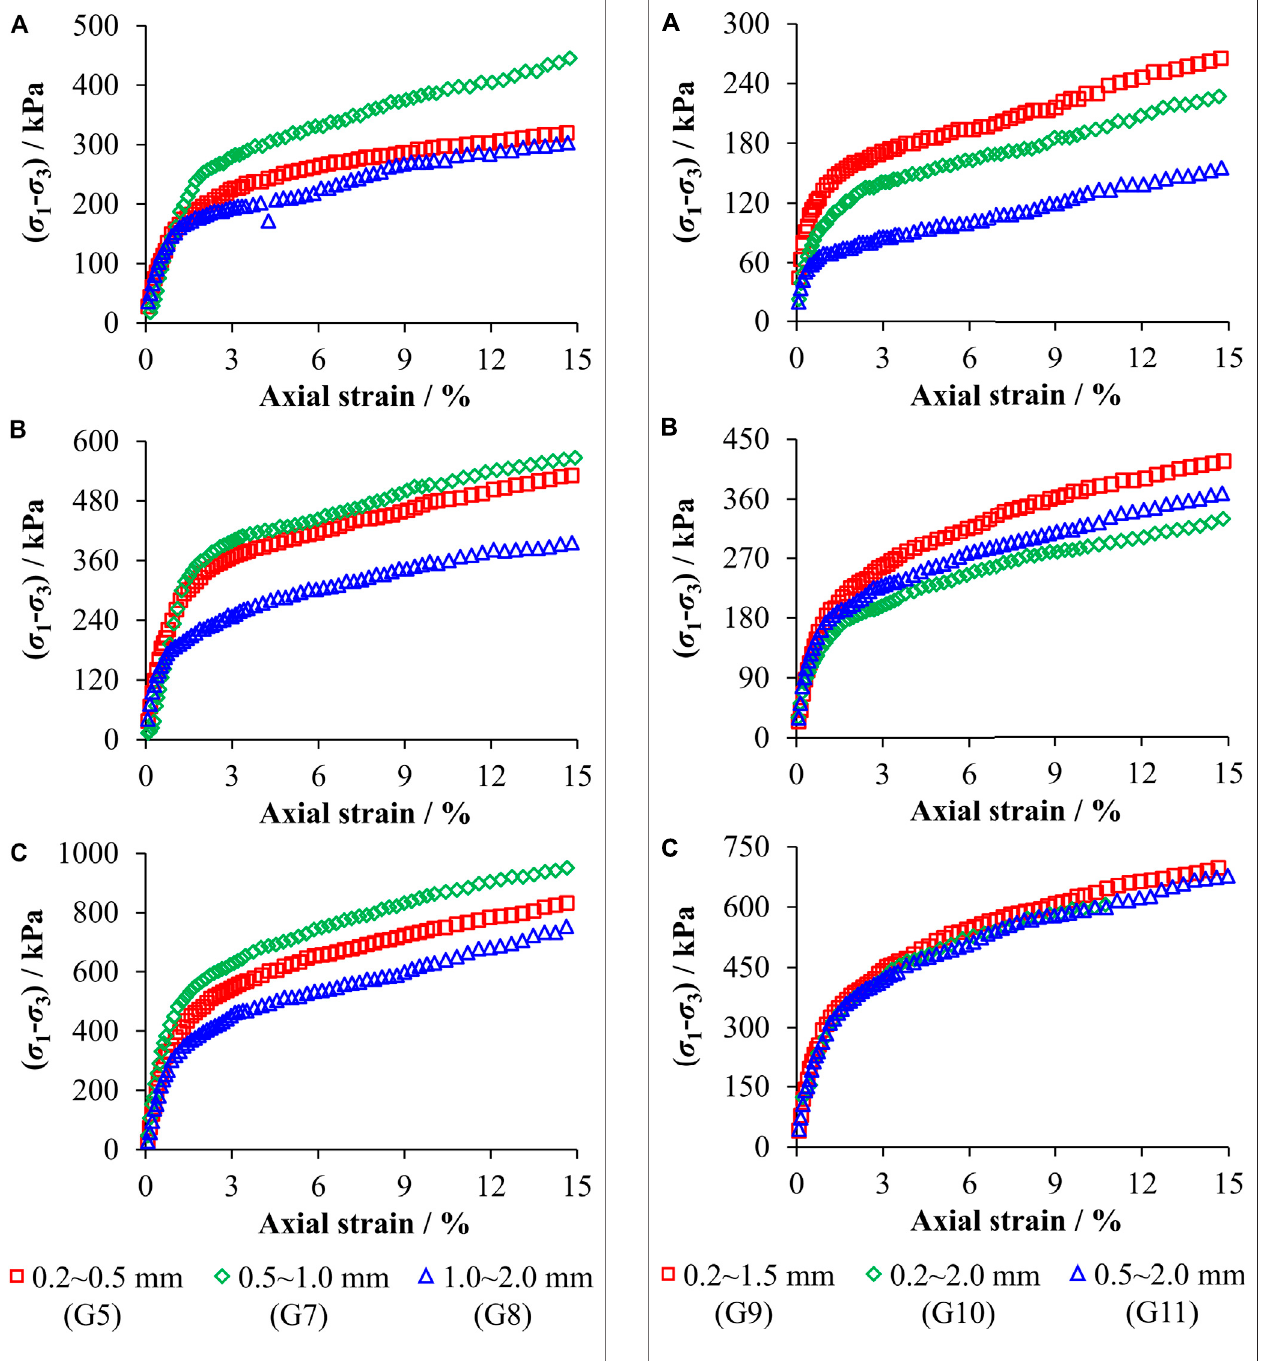
FIGURE 6 | Stress – strain responses of TCS with different particle gradations of fused quartz at con fi ning pressures of 50 (A) , 100 (B) , and 200 kPa (C)